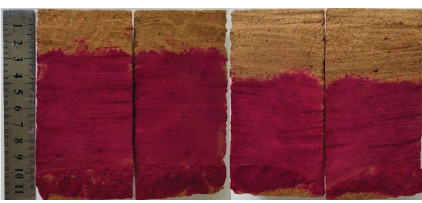
Figure 4: Determination of the carbonation depth of the tested soil.